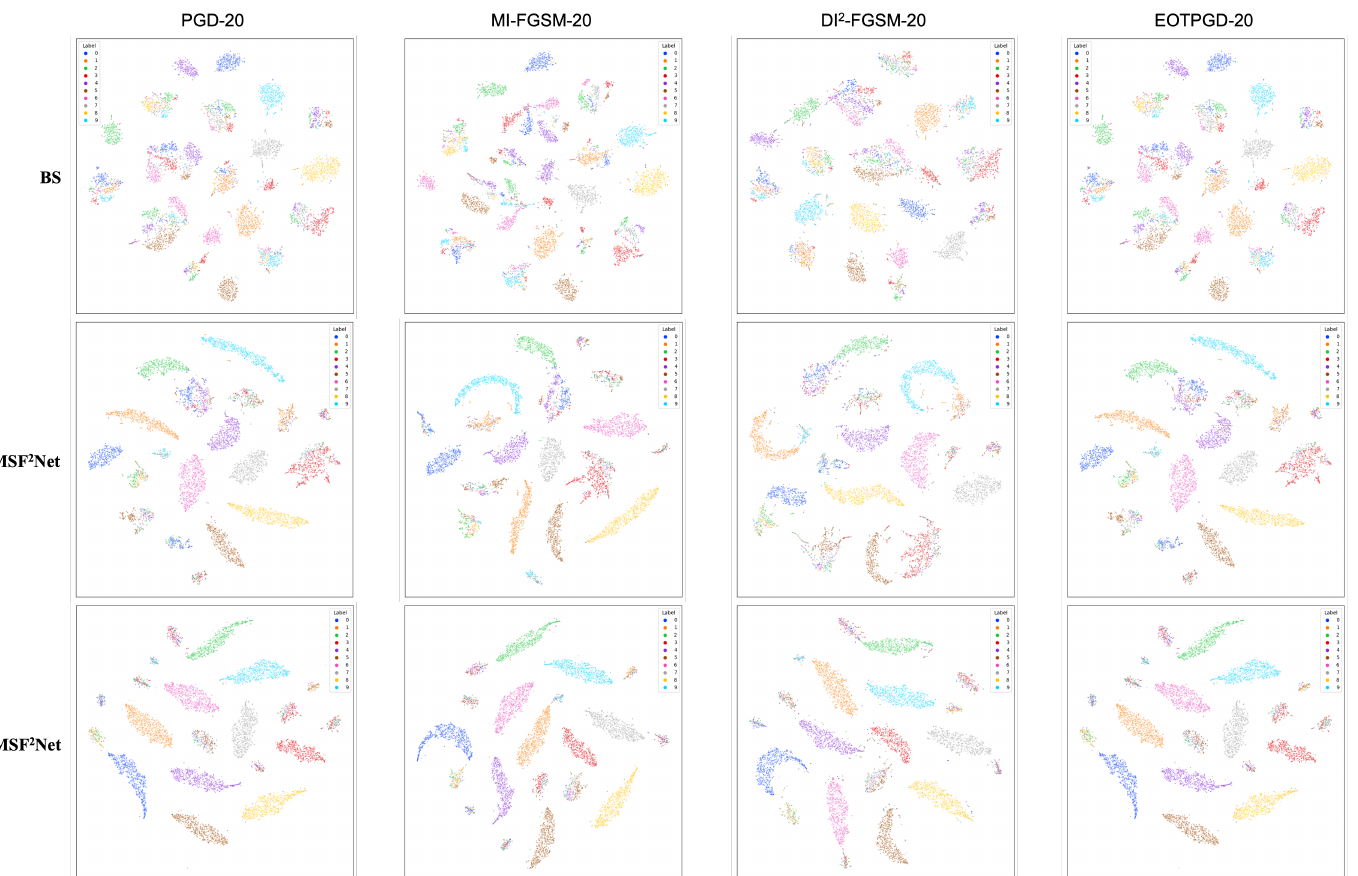
Figure 10. t-SNE visualization results of the baseline, MSF 2 Net, and EMSF 2 Net under the L ∞ -norm attacks with more complexity on the CIFAR-10